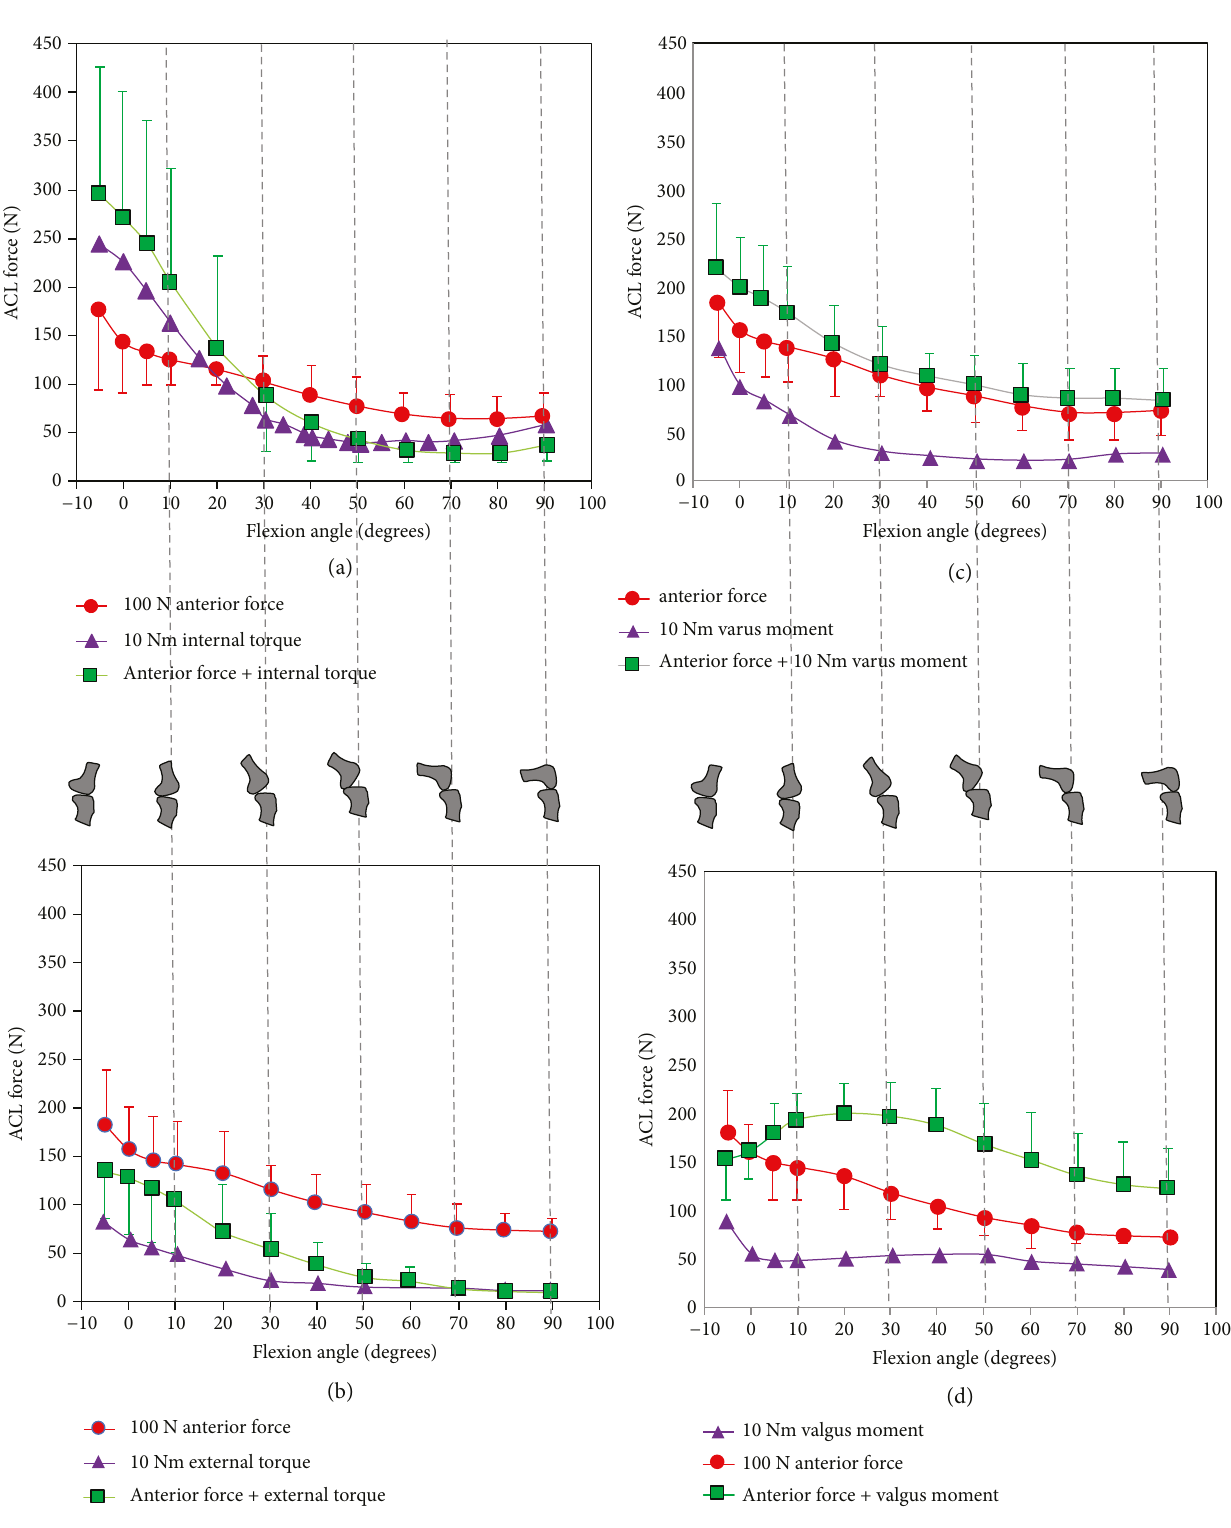
Figure 8: (a, b) The e ff ect of combined loading on ACL force during knee fl exion angles [42]. (c, d) The e ff ect of combined loading on ACL force during knee fl exion angles